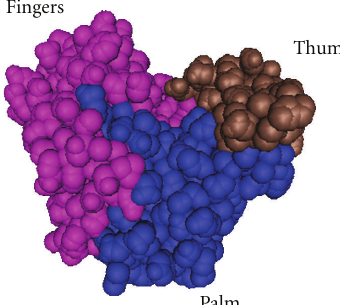
Figure 2: Crystal structure of 3D polymerase from FMDV in the “right-handed” configuration typical of polymerases showing fingers (red), palm (green), and thumb (blue) domains [8]. Structure was obtained from the molecular modeling database (MMDB ID: 29094) at the NCBI web site and illustrated using Cn3D [34,